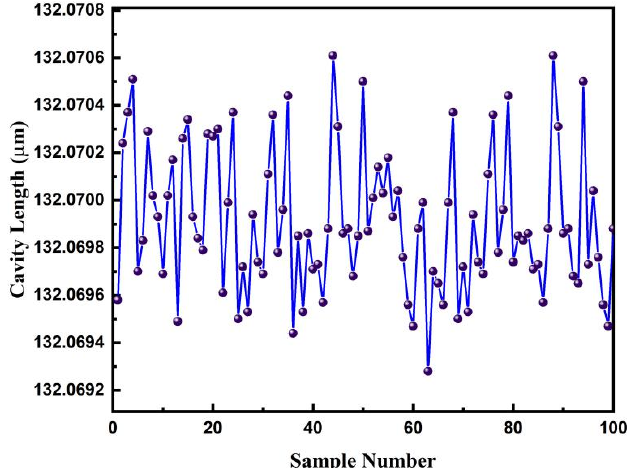
Figure 15. Sampling results from the continuous demodulation of a fiber-optic F–P sensor by the dual SLD cross-correlation demodulation method taken over 100 times.